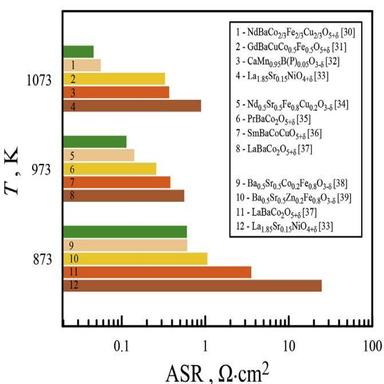
ASR values for selected SOFC cathodes with CeO2ebased electrolyte at different temperatures. Green bars correspond to PYBCN/SDC ¼ 70/30 wt% composite in this work. (For interpretation of the references to colour in this figure legend, the reader is referred to the Web version of this article.)